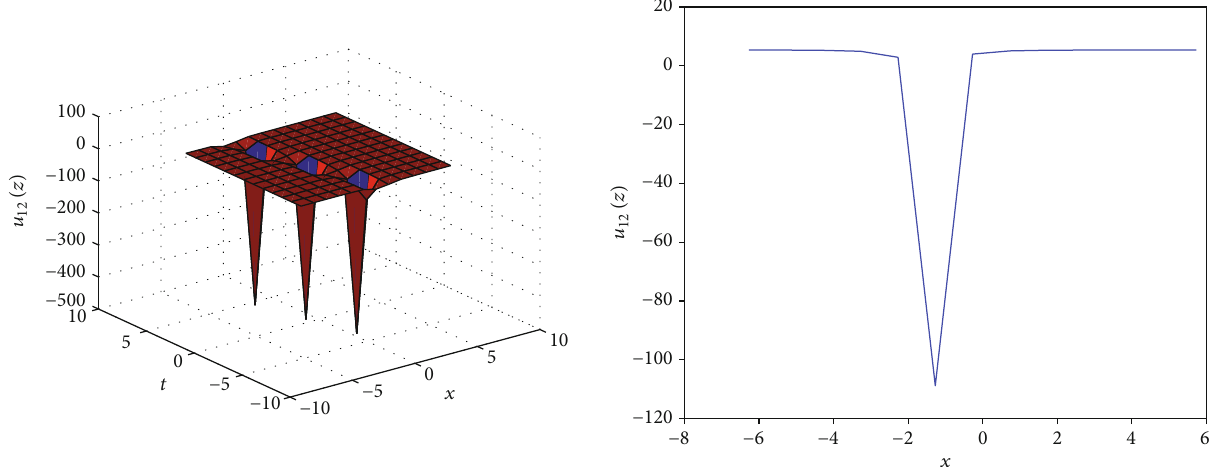
ð z Þ by choosing the values γ = 5 , ϑ = 6 , λ = 1 , ω = 1/4 , c = 1 , and t = 0 for the 2D graphic. Figure 2: The 3D and 2D graphics of u 12